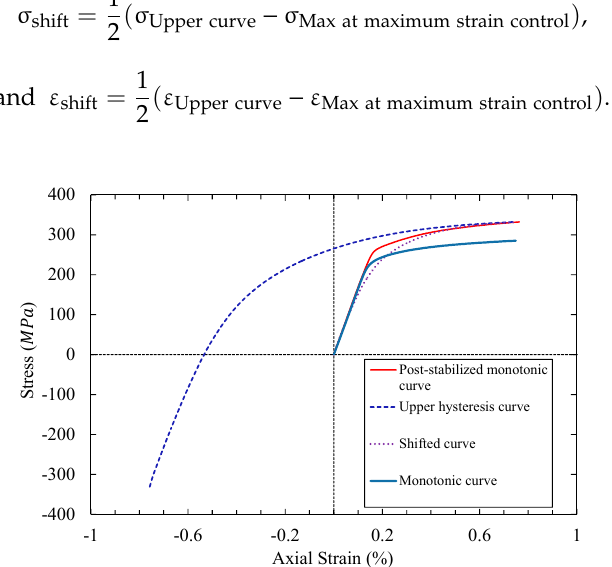
Figure 8. Monotonic, post-stabilized monotonic curves, upper hysteresis curve and shifted curve of AISI 316L SS. Figure 7. Monotonic and post-stabilized monotonic curves of AISI 316L SS.